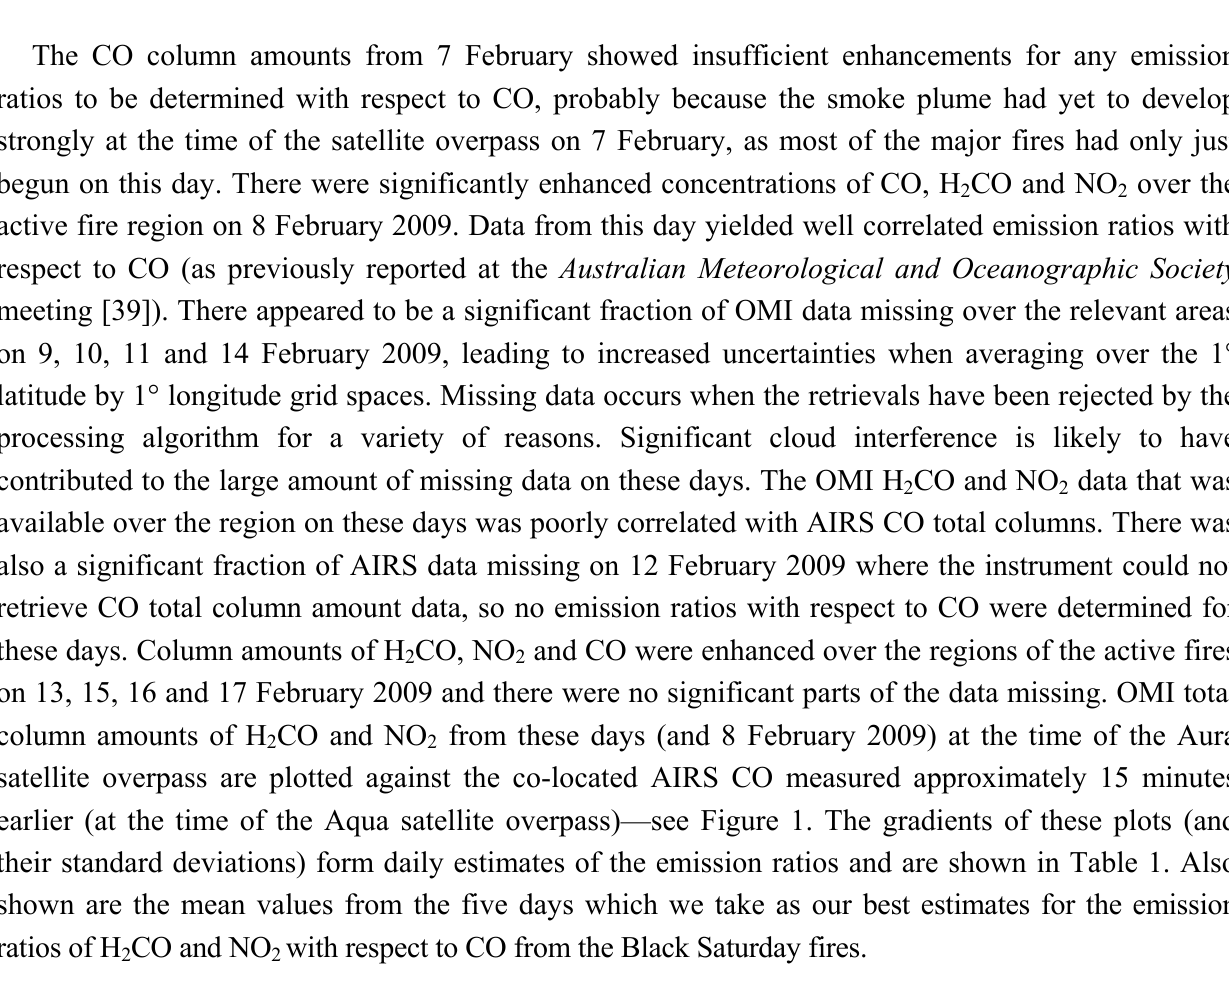
CO and NO with respect to CO in smoke from the active 2 2